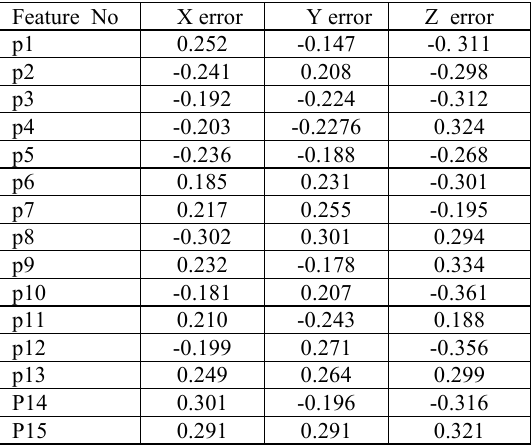
Table 2 the mapping residuals table of the control points As shown in the above Table, we can calculate he average mean square error of X coordinate of the 15 feature points after stereo-mapping is 0.236m, the average mean square error of Y coordinate is 0.223m and the average mean square error of Z coordinate is 0.303m.Through the stereo-mapping residuals of the 15 feature points ,we can draw the conclusion: the accuracy of DLG the we have acquired can meet the requirement of 1:1000 scale mapping, so it is feasible to use UAV borne low- altitude Photogrammetry system for collecting large-scale vector topographic